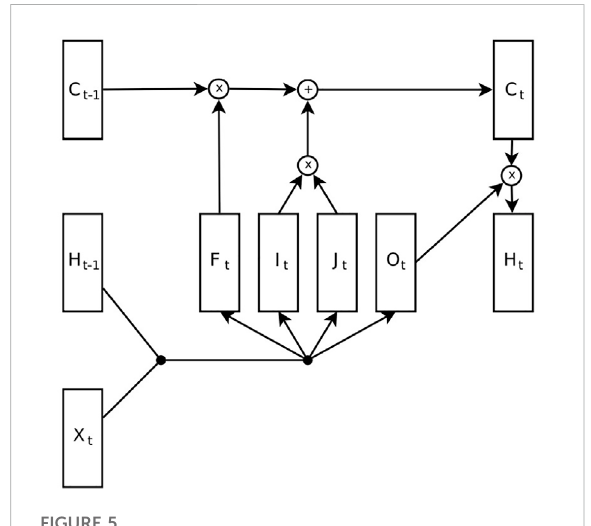
FIGURE 5 Long Short-Term Memory diagram, where C is the memory cell and itcontains thestate. F,I,O arerespectivelytheforget, input and output gates. H is the hidden vector (the output of the network) that depends both on the input X and state C. Original image from Jozefowicz et al.